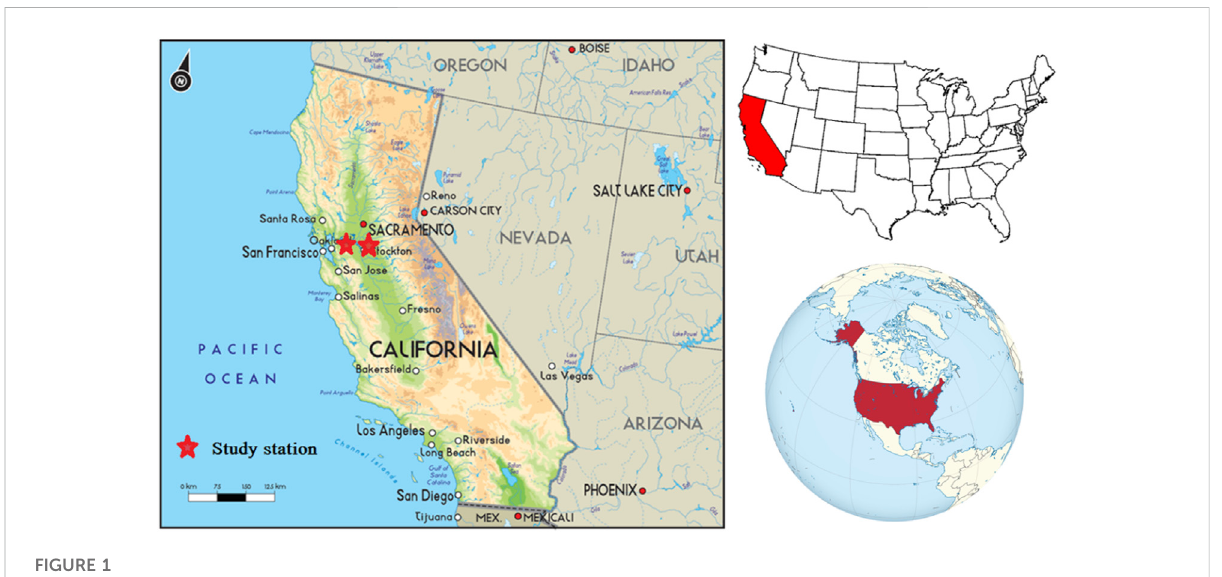
FIGURE 1 Location map of the selected